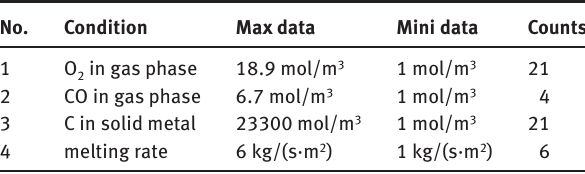
Table 2: Detailed solution conditions